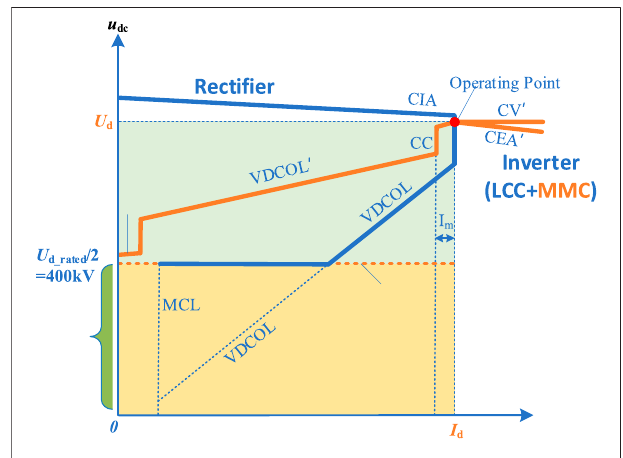
FIGURE 4 | Complete UI curves of Hybrid HVDC when MMCs are in Master-slave control (see Table 2 ).